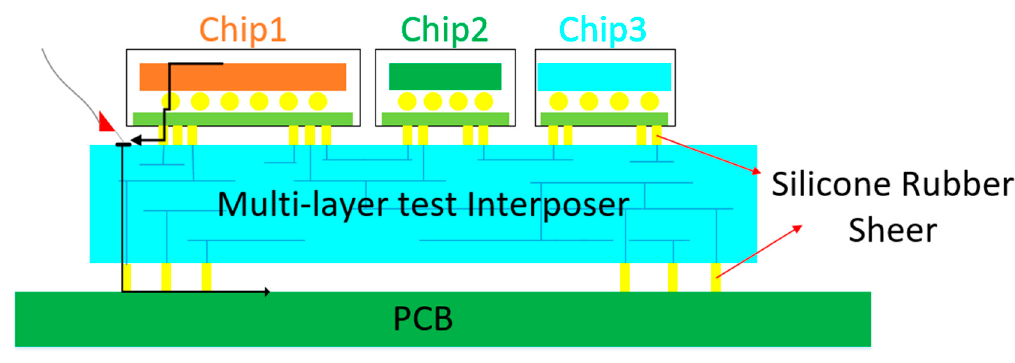
Figure 7. The test interposer for POP.